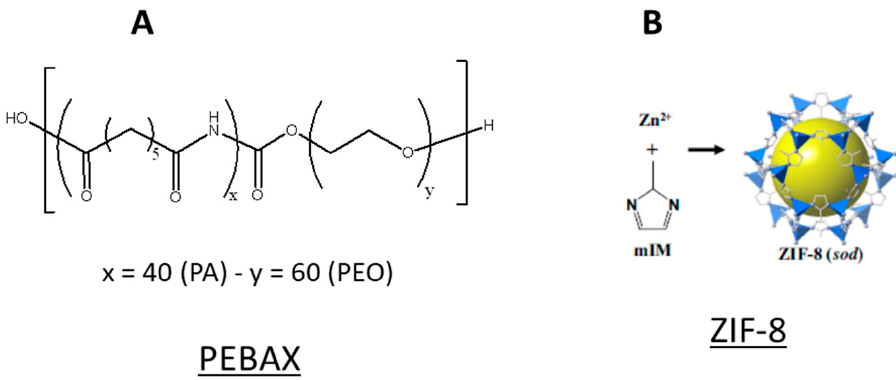
Figure 1. Chemical structure of PEBAX MH1657 ( A ) and ZIF-8 ( B ) [24].